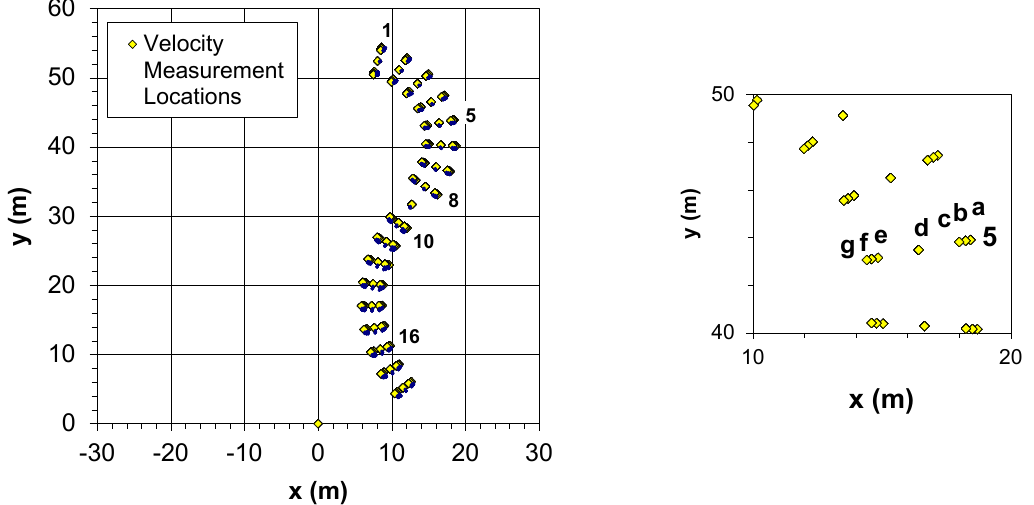
Figure A1. Full plan view ( left ) and close-up plan view ( right ) of physical model velocity profile measurements at cross sections that were numbered from 1 at the upstream end to 18 at the downstream end. At each cross section, the vertical velocity profile positions were designated a–g, left to right looking downstream (left view).